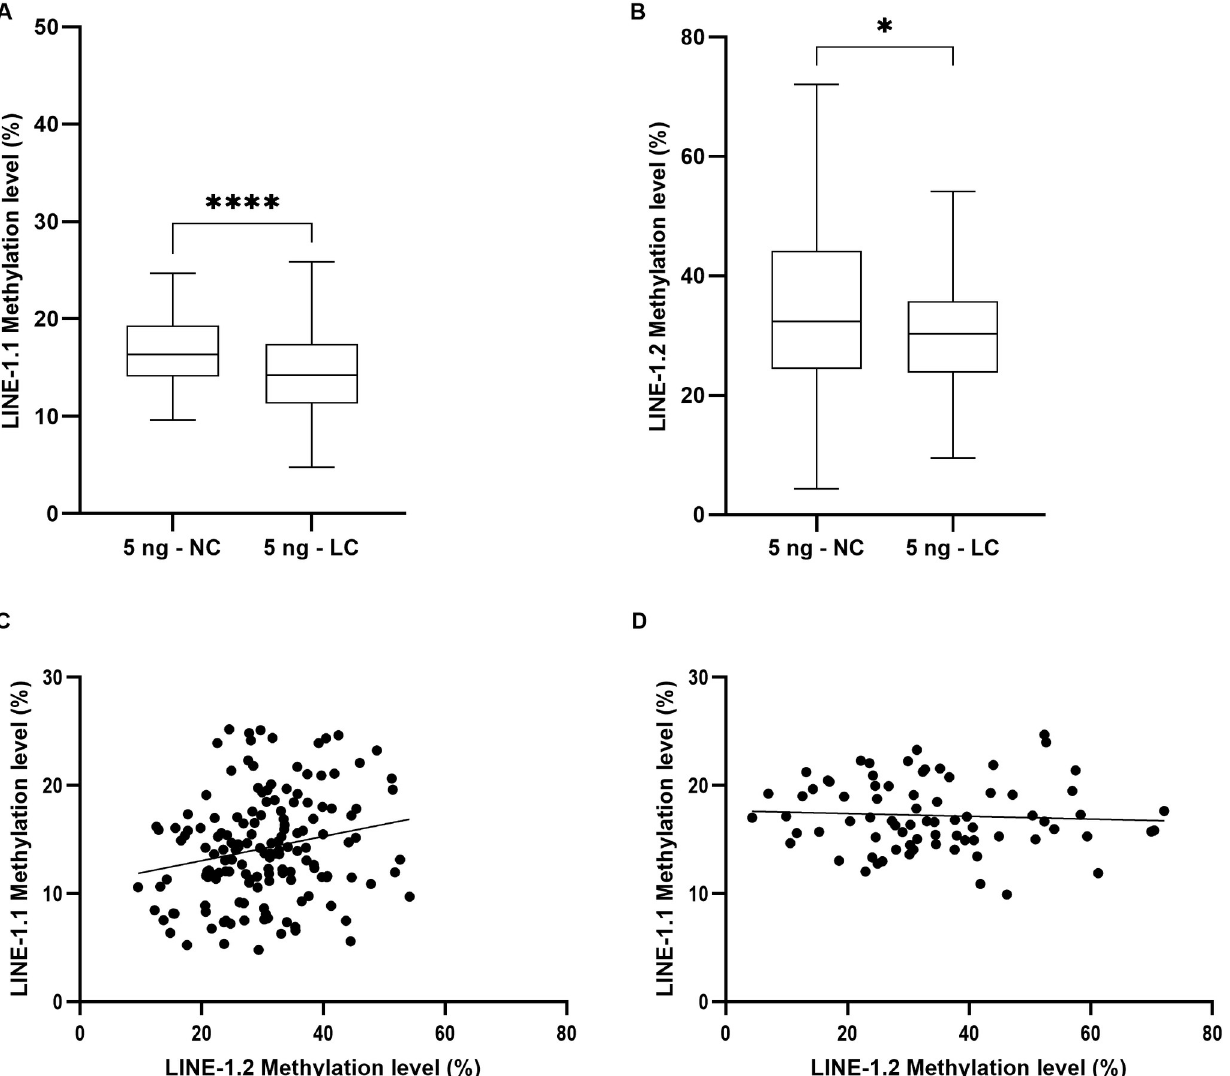
Fig 4. LINE-1 methylation. Hypomethylation of LINE-1 . 1 (A) and LINE-1 . 2 (B) in NC and LC. Linear regression correlation between LINE-1 . 1 and LINE- 1 . 2 in LC group (C) and NC group (D). Methylation measurement was performed on 5 ng of DNA converted by bisulfite. Welch’s t test was used in (A) and (B) while multiple linear regression was used in (C) and (D). ( � ) p < 0.05; ( �� ) p < 0.01; ( ��� ) p < 0.001; ( ���� ) p <